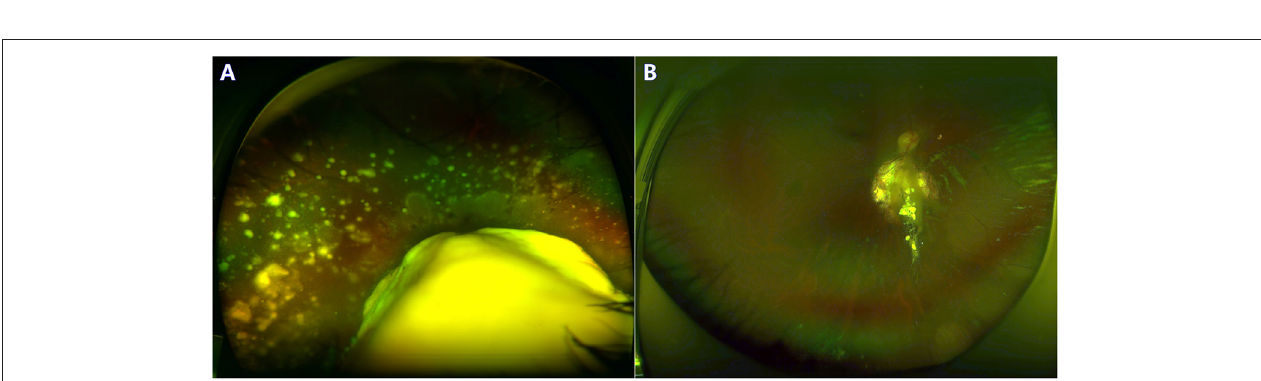
FIGURE 1 | Kaplan–Meier survival curves for 116 patients with advanced unilateral retinoblastoma who were treated with primary IAC treatment. Recurrence-free survival (A) and ocular survival (B) . Patients’ eyes were divided into groups according to the IIRC.